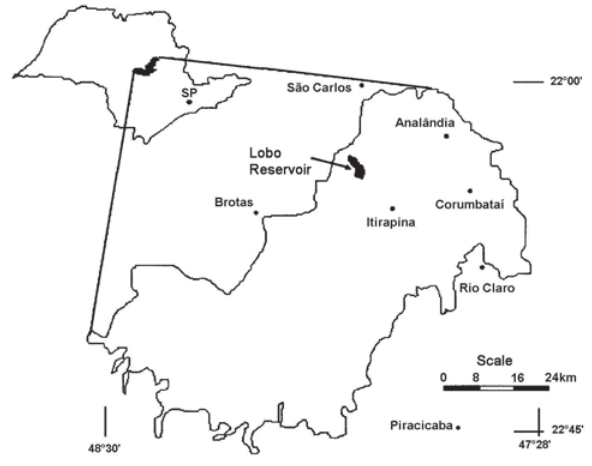
Fig. 1. Map showing the location of Lobo Reservoir in the Corumbataí/Botucatu/Tejupá APA, São Paulo State. (Source: Marinelli,